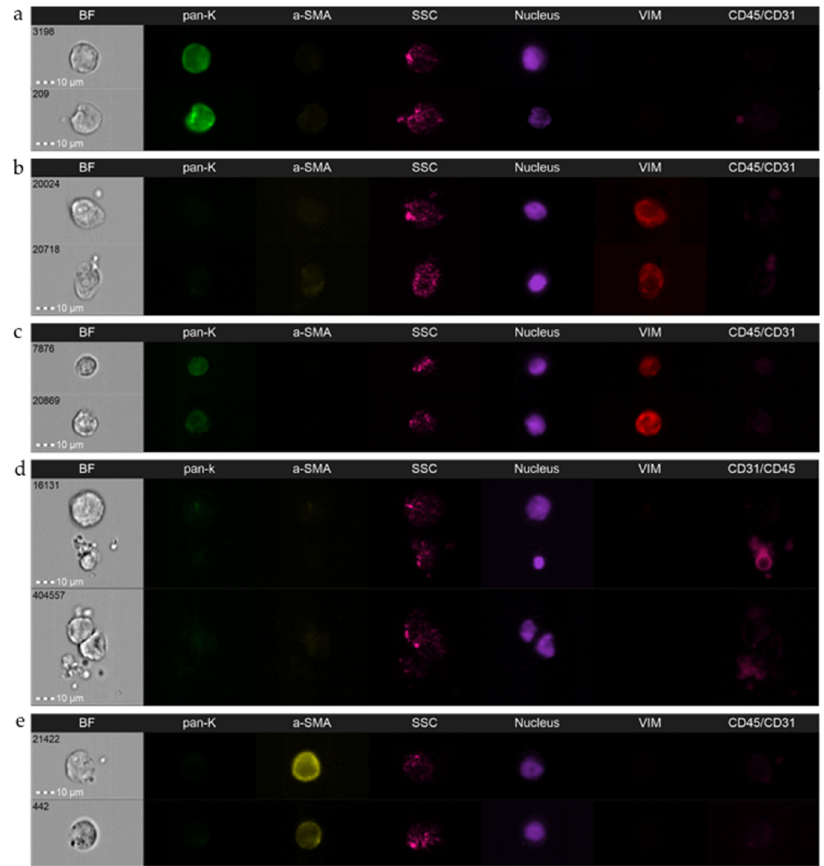
Figure 1. Representative pictures of the spectrum of epithelial-to-mesenchymal phenotypes in circulating tumor cells are detected using imaging flow cytometry in breast cancer patients: ( a ) epithelial CTC, ( b ) mesenchymal CTC, ( c ) epithelial–mesenchymal CTC, ( d ) double negative CTC, and ( e ) circulating cancer-associated fibroblasts. BF—brightfield; pan-K—pan-keratins; a-SMA—alpha-smooth muscle actin; SSC—side scatter; Vim—vimentin; CD45/CD31—leukocyte/endothelial cell marker. Amnis ® ImageStream ® X Mk II (Luminex, Austin, TX, USA), objective 40×.